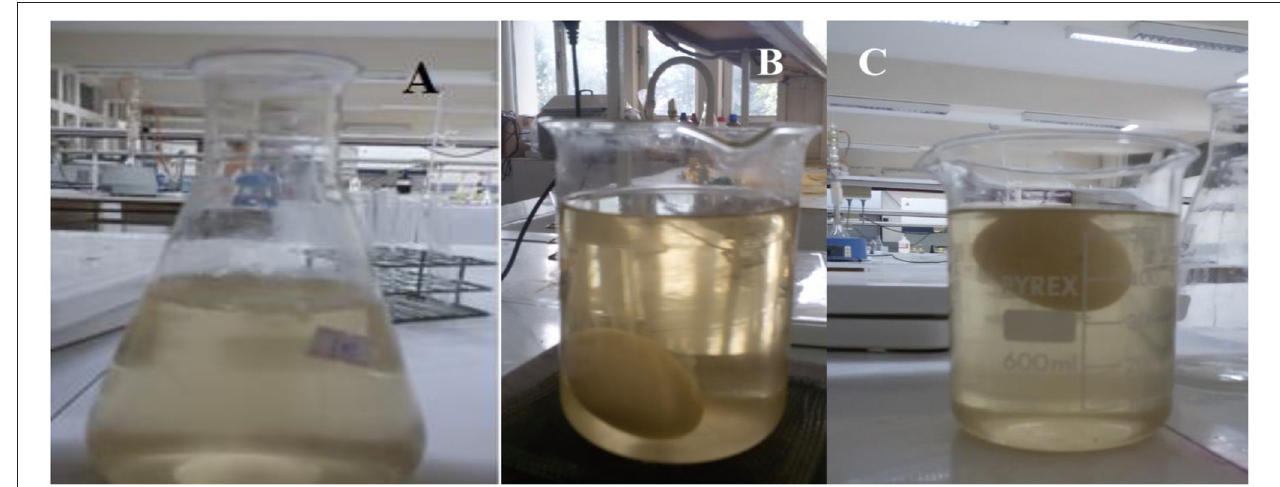
FIGURE 5 | The prepared lye solution (A) , less concentrated lye (B) , and concentrated lye solution (C)